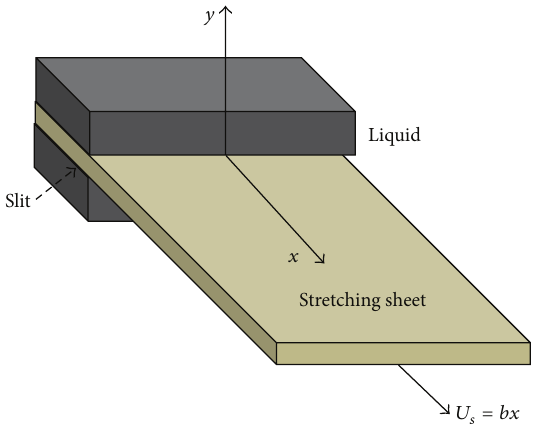
Figure 1: Schematic diagram showing the physical configuration and coordinate